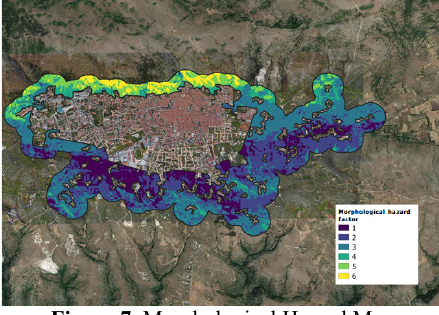
Figure 7 . Morphological Hazard Map